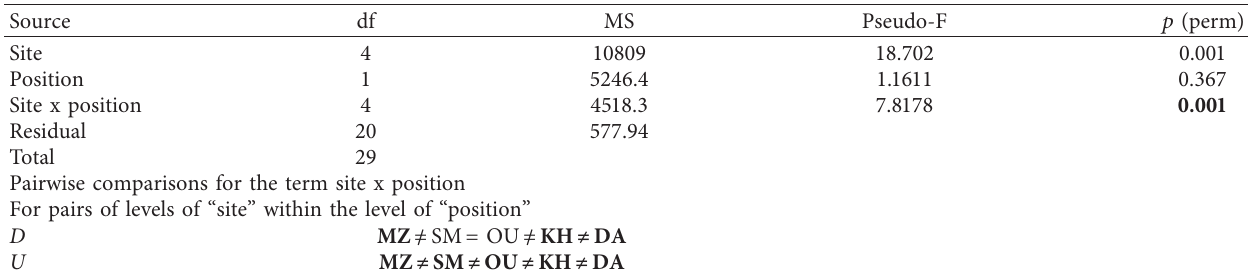
Figure 2: Pearson’s correlation analyses of mean species richness of Z. noltei beds present in the sampled sites with latitude. Samples were collected from downstream and upstream stations of five semi-enclosed coastal ecosystems along the Atlantic coast of Morocco. Grey shaded area: 95% confidence intervals of best-fit Table 5: Results of the multivariate permutational analysis (PERMANOVA) for benthic assemblages considering “site” (5 levels, random) and “position” (2 levels, fixed) factors. Analyses are based on Bray–Curtis similarity matrixes from fourth root transformed data; Df � degrees of freedom; MS � mean square; and p (perm) � level of significance.